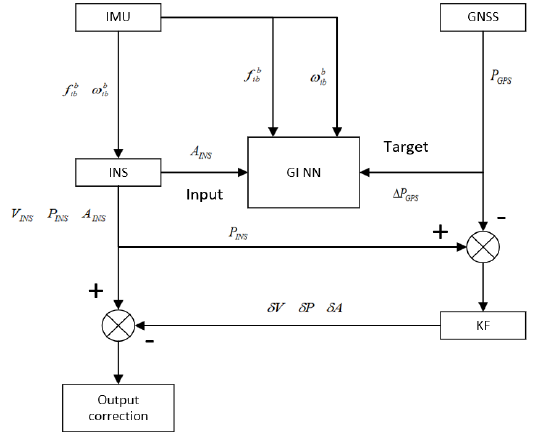
Figure 4 . Structure diagram of GI-NN auxiliary GNSS/INS integrated navigation system during online